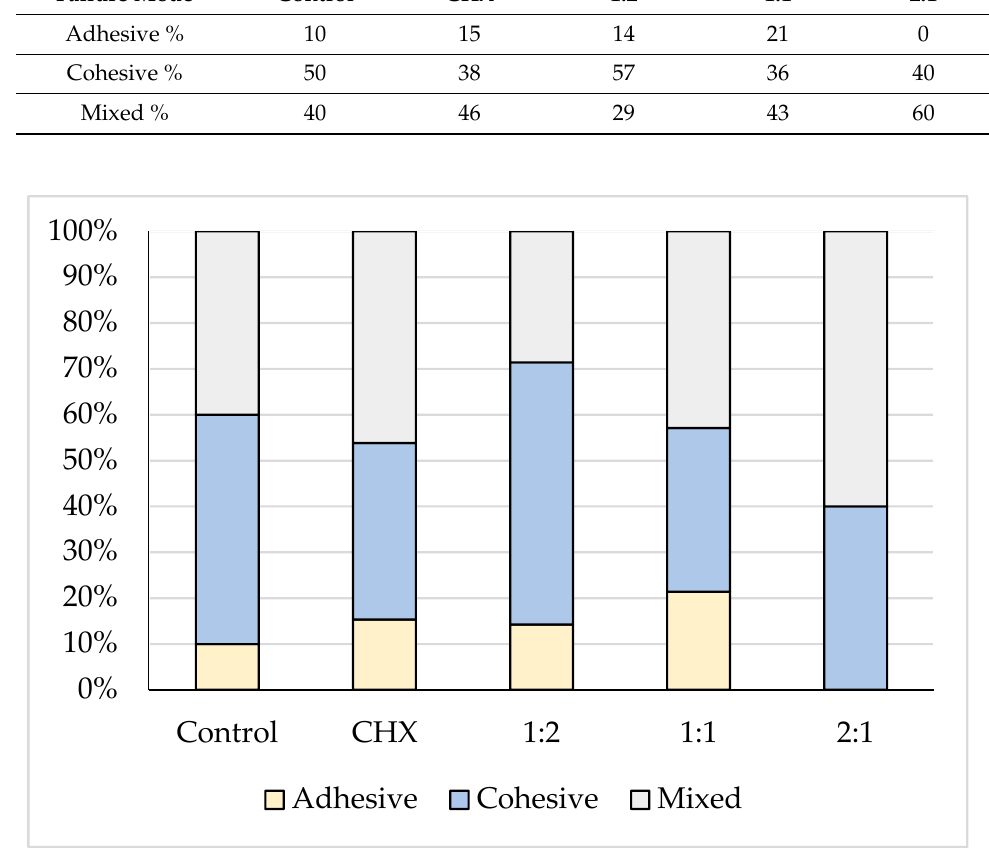
Figure 2. A stacked column chart showing the different failure modes of the five tested groups.